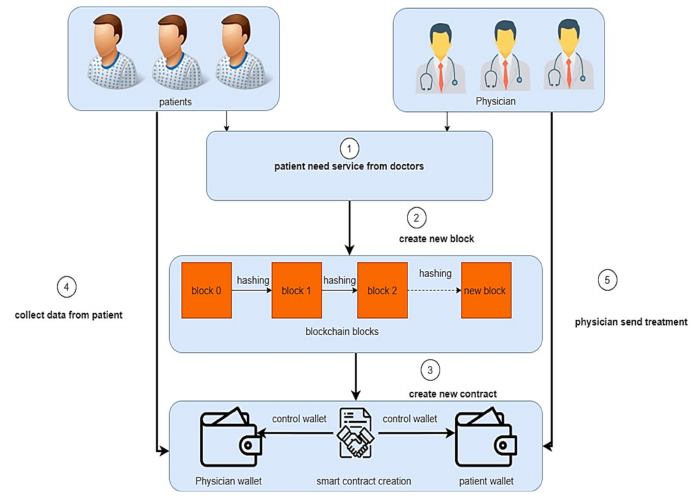
Figure 1. The proposed framework.